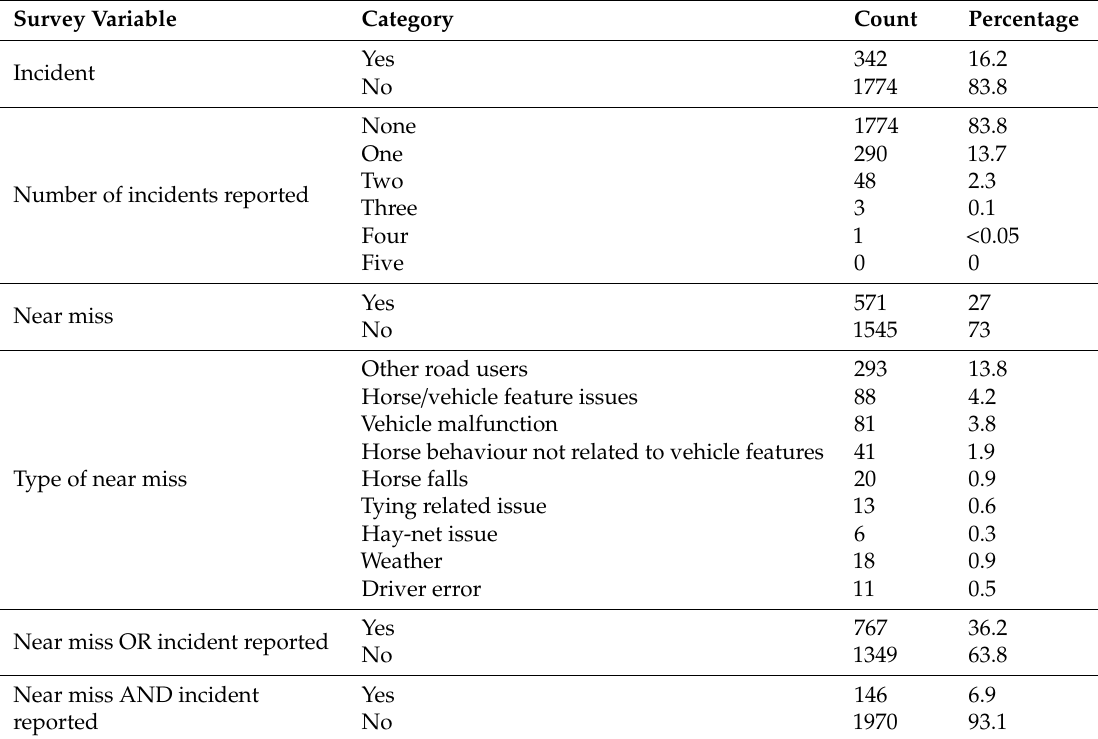
Table 4. The counts and percentage breakdown of incidents and near misses (including the frequency of di ff erent types of near miss) reported by the survey population (n = 2116).